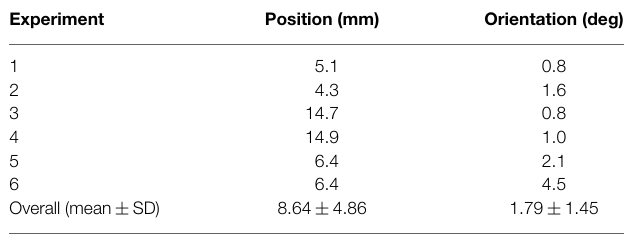
TABLE 2 | US probe placement position and orientation difference